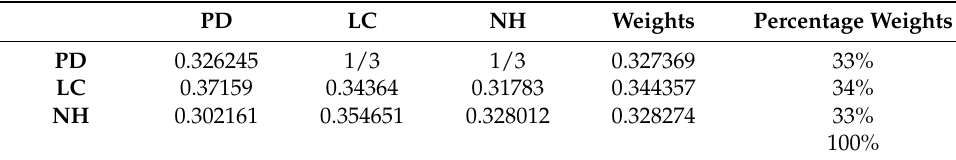
Table 4. Standard matrix for exposure Table 3. Standard matrix vulnerability parameters.